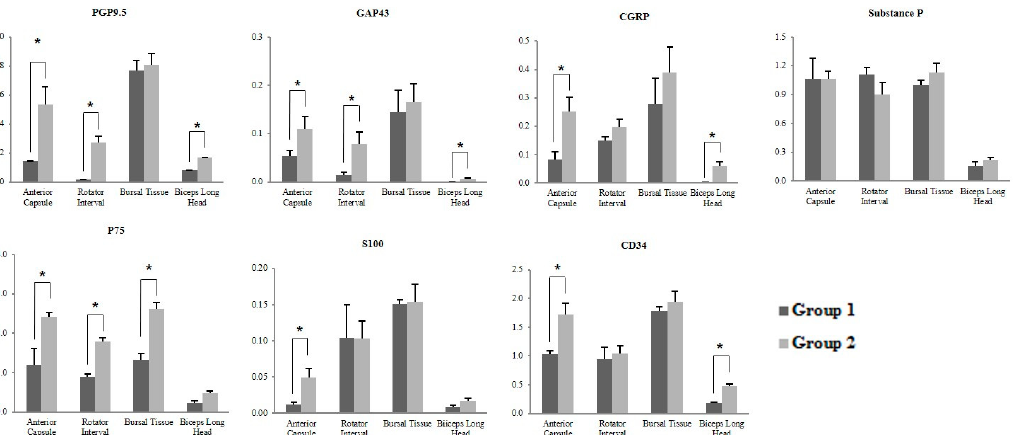
Figure 1. The gene expression levels of PGP 9.5, GAP43, CGRP, substance p , P75, S100, and CD34 in the anterior capsule, rotator interval, subacromial bursa, and biceps long head. PGP9.5, protein gene product 9.5; GAP43, growth-associated protein 43; CGRP, calcitonin gene-related peptide. * p < 0.05. The majority of the expression of pain-related factors in adjacent structures was higher in group 2 with the abnormal LHBTs when compared to group 1 with the normal LHBTs. In the anterior capsule, the expressions of PGP9.5 (0.014 vs. 0.054, p = 0.004), GAP43 (0.054 vs. 0.110, p = 0.02), CGRP ( p = 0.081 vs. 0.252, p = 0.005), P75 (1.199 vs. 2.417, p = 0.02), S100 (0.013 vs. 0.049, p = 0.008), and CD34 (1.035 vs. 1.721, p = 0.005) were significantly higher in group 2. In the rotator interval, PGP9.5 (0.002 vs. 0.027, p = 0.01), GAP43 (0.014 vs. 0.017, p = 0.004), and P75 (0.886 vs. 1.782, p = 0.02) were more highly